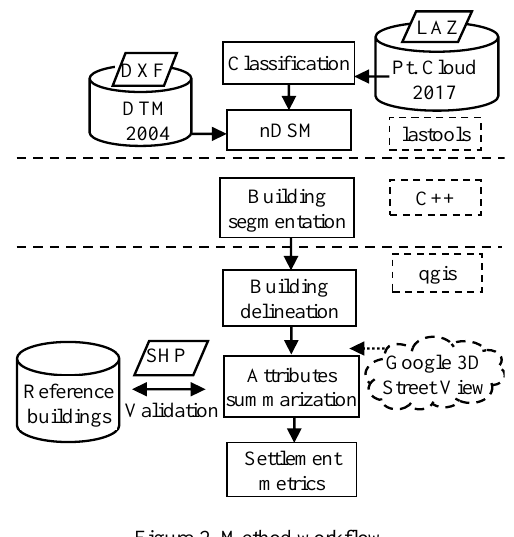
Figure 2. Method workflow